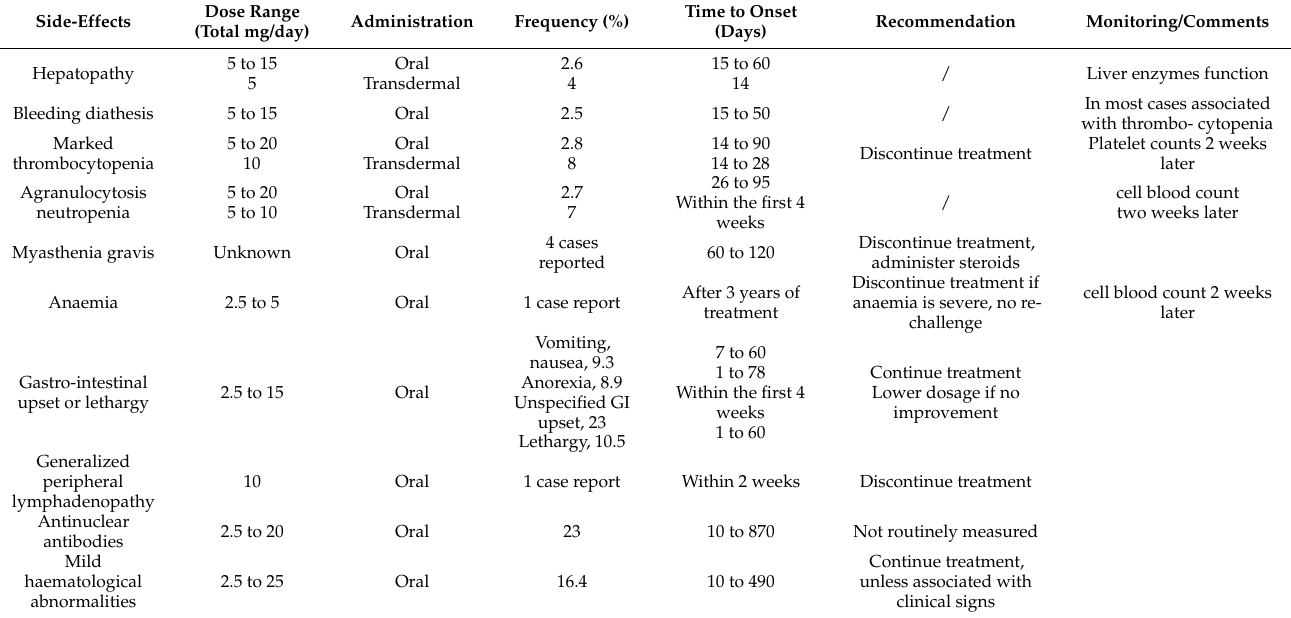
Table 1. Suspected adverse drug reactions to oral and transdermal methimazole (modified from [28]).